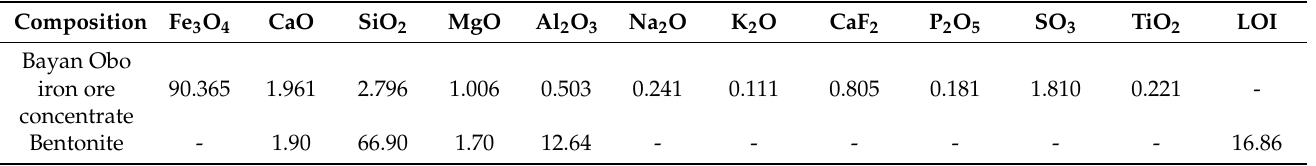
Table 1. Chemical composition of raw materials/wt%.